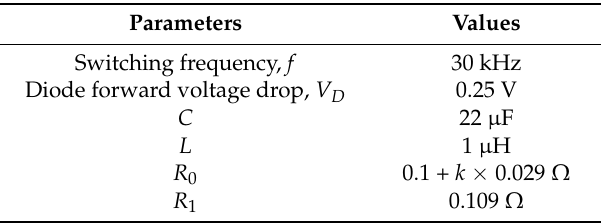
Table 1. Key parameters of the simulation model.